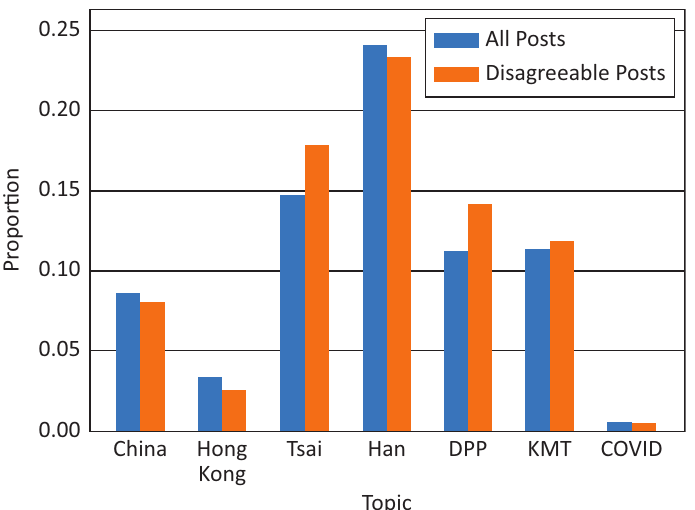
Figure 3. Proportion of article topics by the level of disagreement. Note: The figure shows that posts about Tsai and the DPP yield more disagreement in the discussion